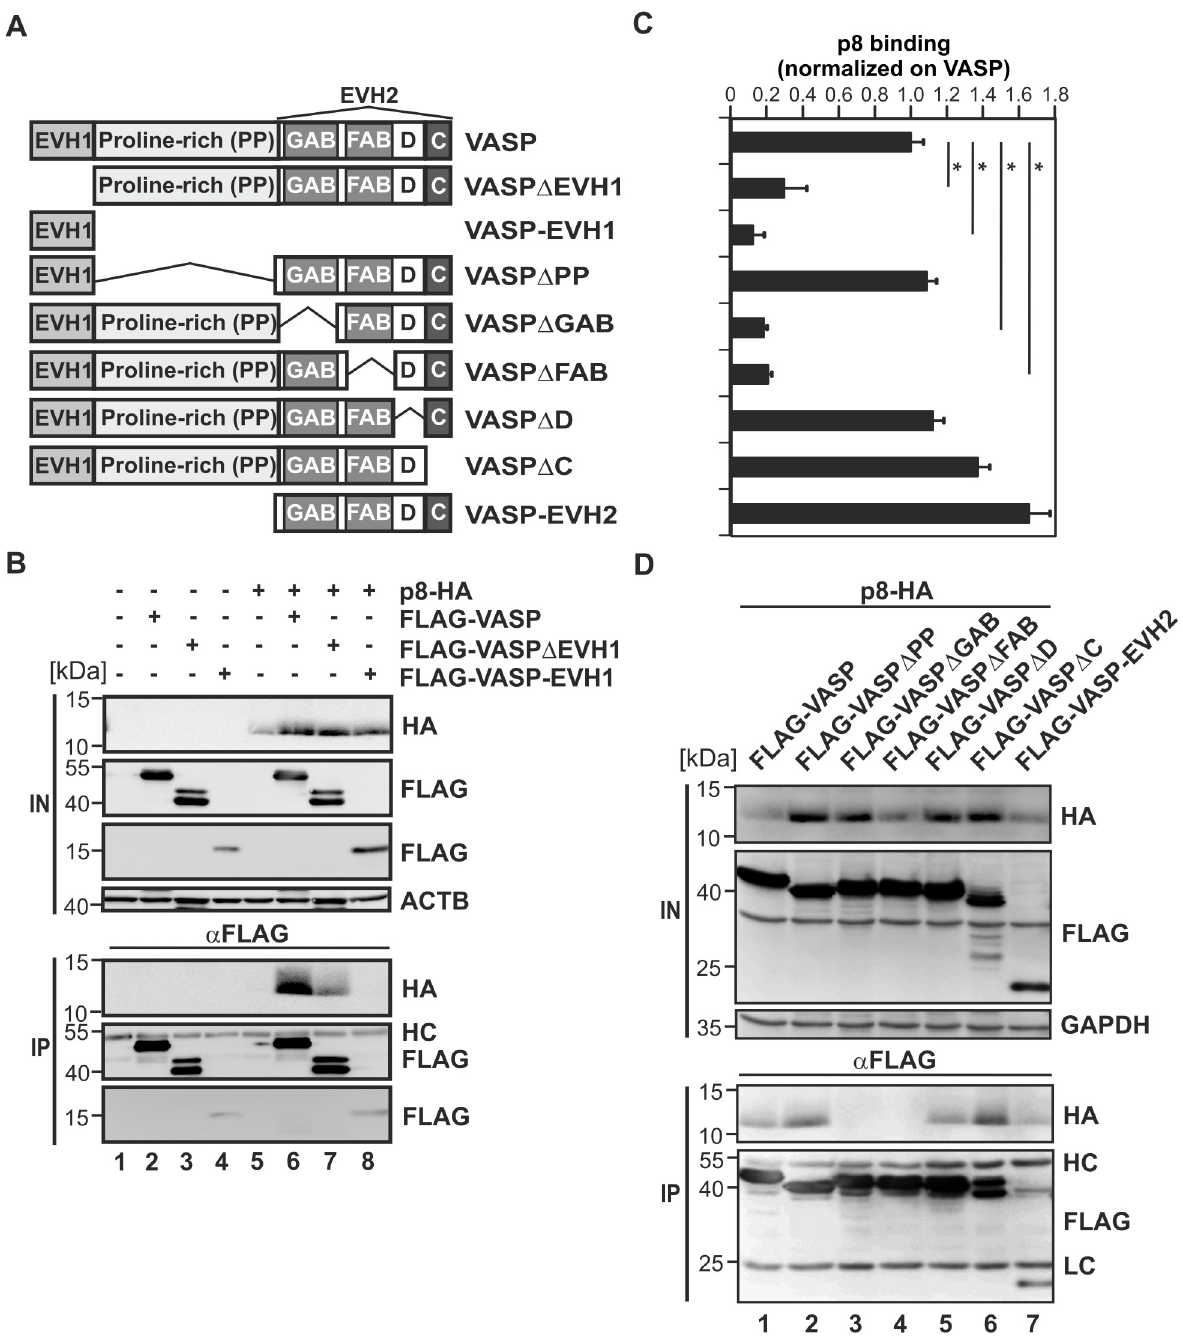
Fig 2. The EVH1-domain and the F- and G-actin binding domains of VASP are required for the interaction with p8. (A) Domain structure of VASP protein and mutants. (B) 293T cells were transfected with expression plasmids p8-HA and FLAG-VASP, FLAG-VASP Δ EVH1, FLAG-VASP-EVH1 or the respective empty control vectors. After 48 h, cells were lysed and 10% of the lysates were taken as input (IN). Co- immunoprecipitations (IPs) were performed using anti-FLAG antibodies. Immunoblots are shown. HC, heavy chain. One representative out of four independent experiments is shown. (C) Densitometry was performed to quantitate the amount of p8-HA after precipitation and values were normalized on the respective FLAG-VASP expression in the input. p8 binding to VASP wildtype was set to 100%. Bars indicate the means of four independent experiments ± SE and values were compared to VASP wildtype using Student’s t-test. � indicates p < 0.05. (D) 293T cells were transfected with expression plasmids p8-HA and FLAG-VASP, FLAG-VASP Δ PP, FLAG-VASP Δ GAB, FLAG-VASP Δ FAB, FLAG-VASP Δ D, FLAG-VASP Δ C or FLAG-EVH2. IPs were performed as described in (A) . One representative out of four independent experiments is shown.